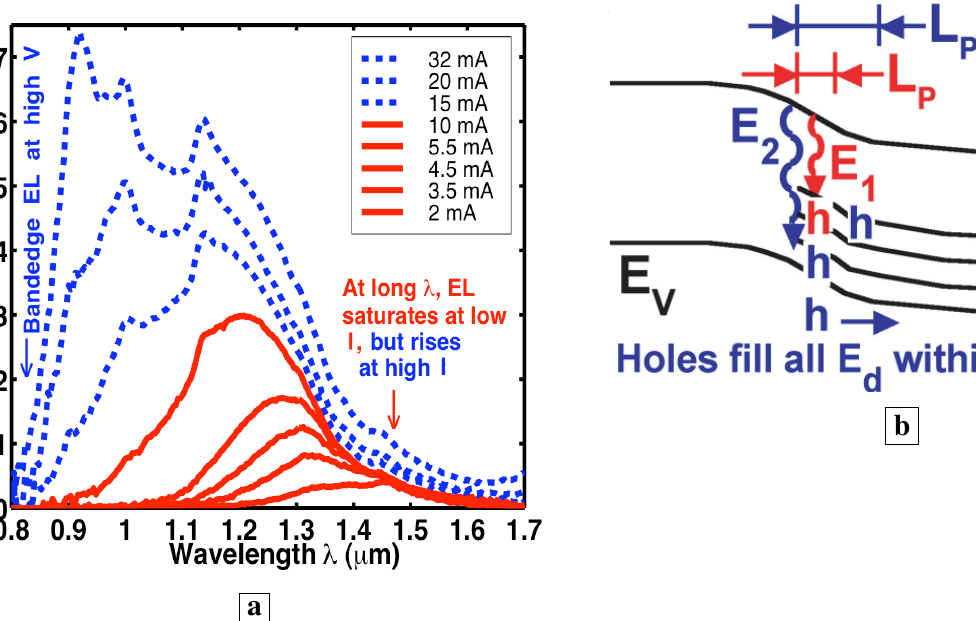
Figure 8 . a, Room temperature EL spectra [7] of p-n junction with the deep-center-layer as the n-region. b, Energy band diagram showing the p-layer on the left and the n-type deep-center layer on the right. At low injection, free holes are captured onto deep-centers within one L of the p-n junction, and scatter up to midgap states. (Holes are labeled in red). P At higher injection, the additional holes fill all deep-states within one L from the midgap down to the valence-band. As these deep-states fill up, the EL saturates at the long wavelengths corresponding to transitions to these